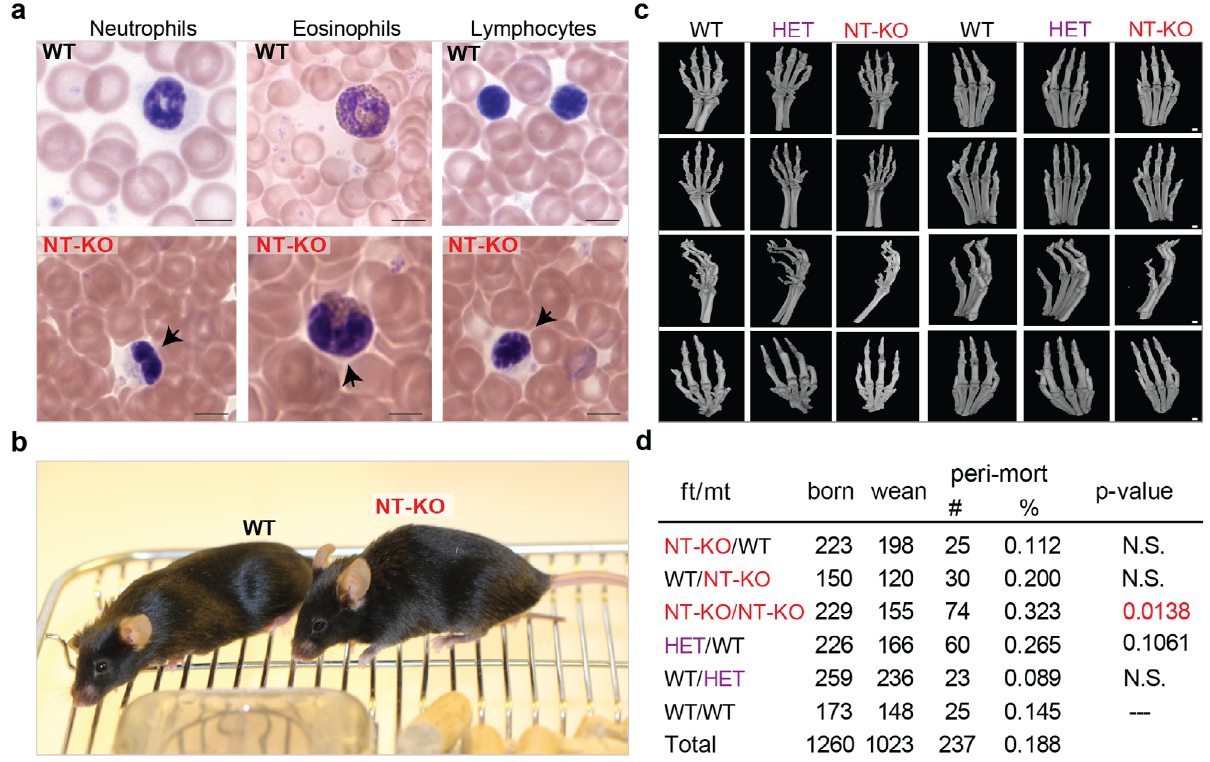
Fig. 1 LBR NT-KO mice show laminopathy defects and increased perinatal mortality but not skin or skeletal defects. a Top, Pelguer – Huet characteristic neutrophil and eosinophil and lymphocyte chromatin defects are shown (blood from female animals are presented, but no sex-speci fi c effect has been observed). Black arrows in LBR NT-KO animals indicate defects in chromatin organization in the shown cell types. Scale bar indicates 5 µ m. b No skin/fur defects were observed in LBR NT-KO animals. A female adult WT and a LBR NT-KO mouse are shown next to each other are shown. c No skeletal defects in front (left) and rear (right) paws have been observed in any analyzed category (female animals are shown in this fi gure, but no sex-speci fi c effect has been observed). Scale bar indicates 1 mm. d The table shows perinatal mortality from different classes of crosses indicating the parental origin of